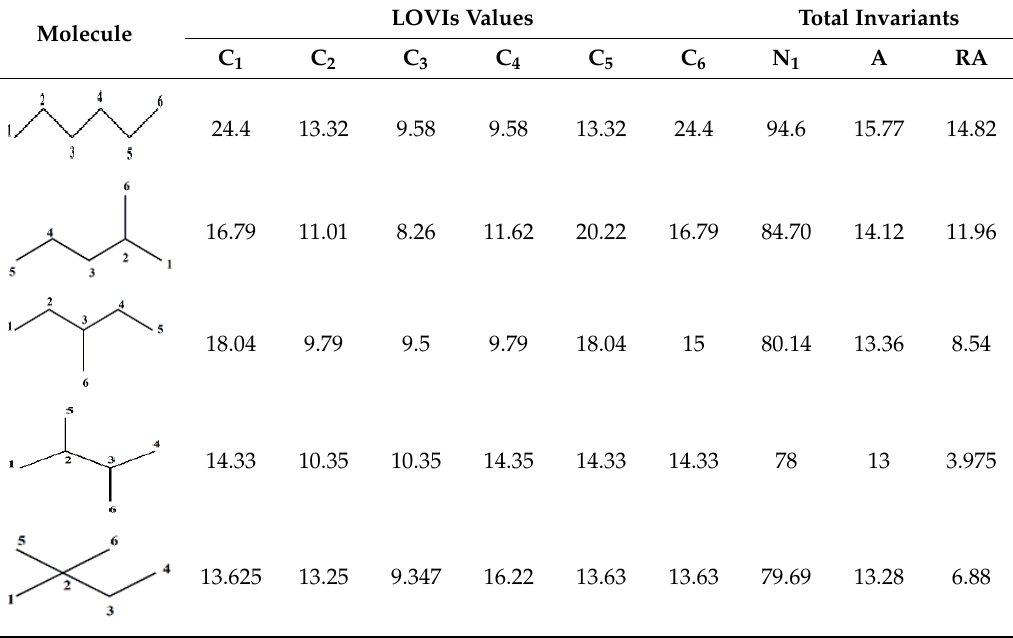
Table 3. Differentiation among chain isomers.